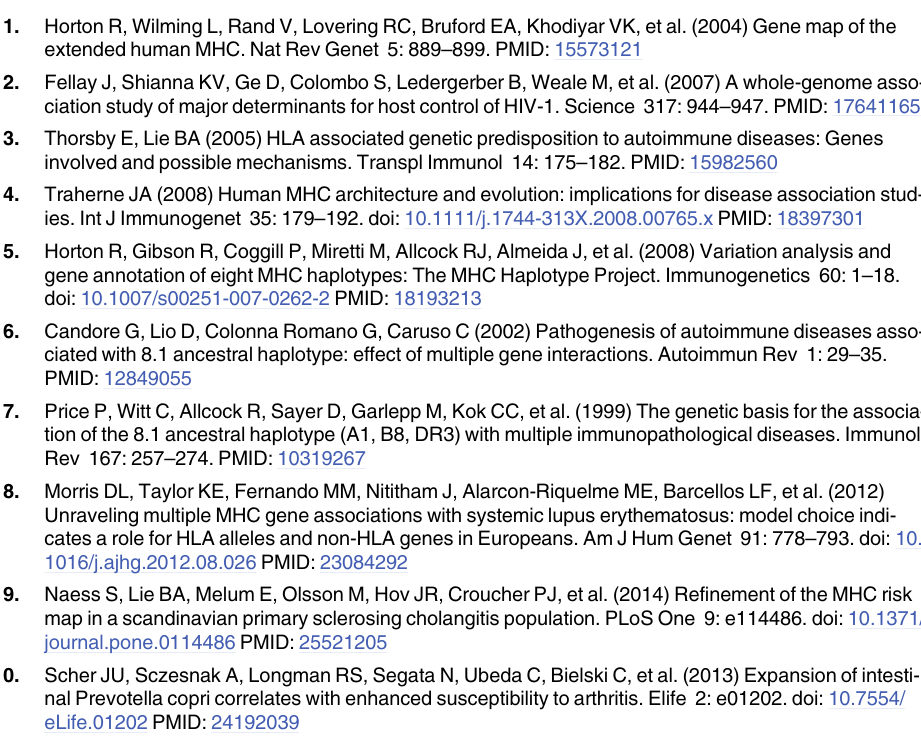
S1 Table. Overview of included individuals, their HLA-B and HLA-DRB1 types and geno- type